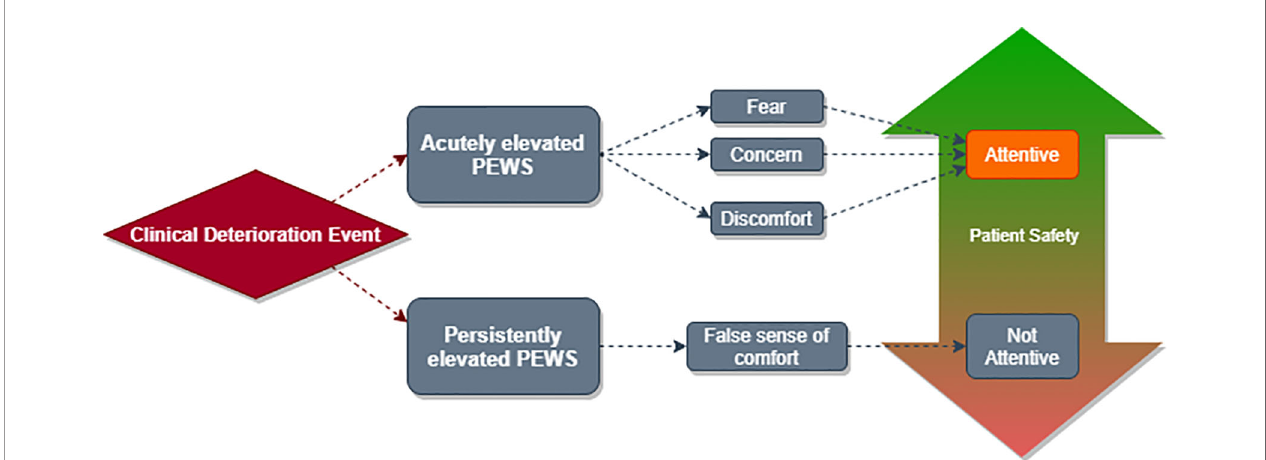
FIGURE 1 | Interaction between clinical deterioration events, PEWS scores, provider emotions, and patient safety. Clinical deterioration events result in elevated PEWS scores. If a PEWS score is elevated acutely, as it may be at the beginning of a deterioration event, clinicians experience emotions such as fear, concern, and discomfort. These emotions may be negative as experienced and described by clinicians; however they often lead to increased patient attention and safety. Conversely, a persistently elevated PEWS score may lead clinicians to experience a false sense of comfort which results in decreased attention and reduced patient